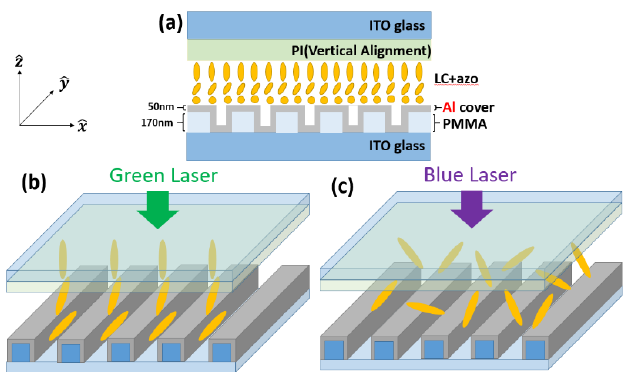
Figure 1. ( a ) Sample structure: LC aligned in HAN mode; ( b ) Green pumping laser switching azo dye to final trans-state in which the LC molecules are aligned in hybrid mode; ( c ) Blue laser switching azo dye molecules to final cis-state, wherein the LC layer is isotropic.